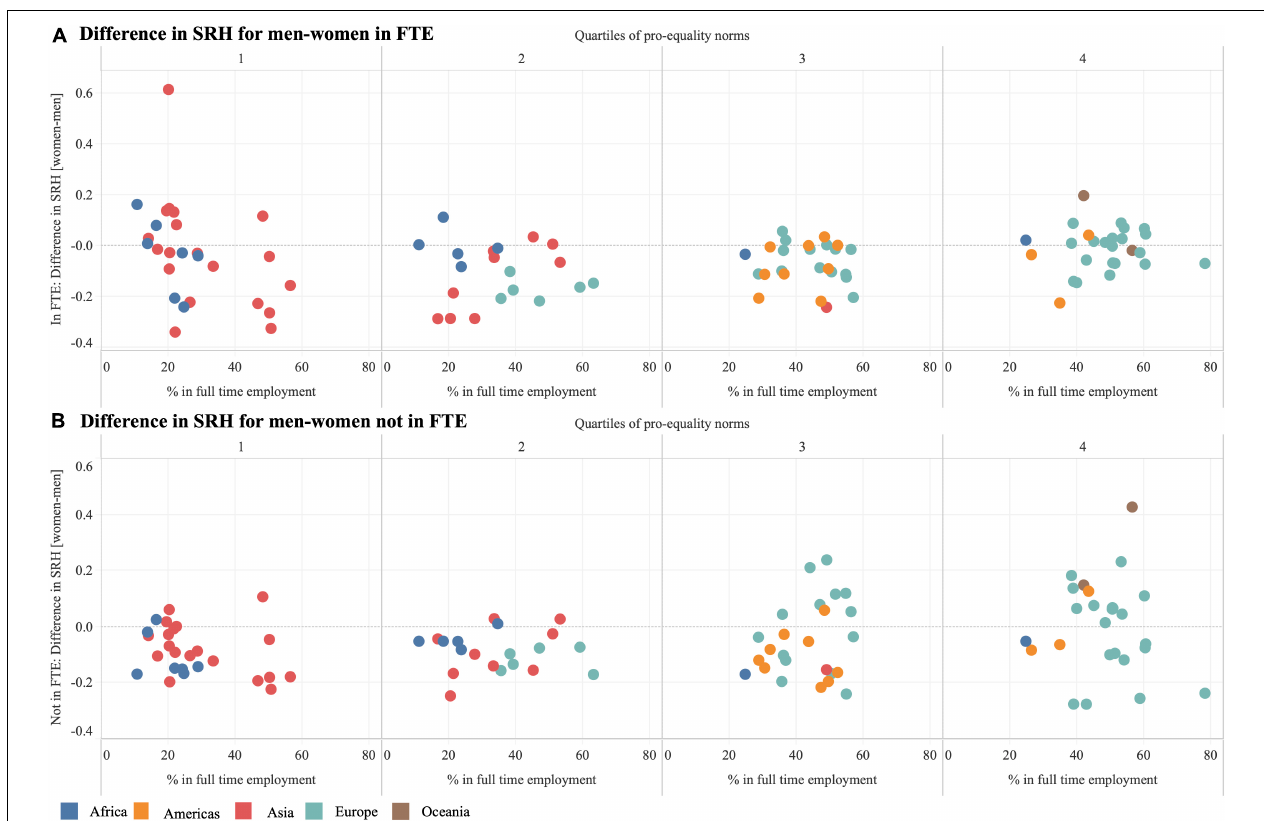
FIGURE 3 | Differences in self-reported health (SRH) for women compared to men among (A) those in full-time employment (FTE) and (B) those not in FTE. Negative values indicate that SRH is lower among women compared to men. Each dot represents a country and colors indicate UN Regions. Countries are grouped based on quartiles of pro-equality